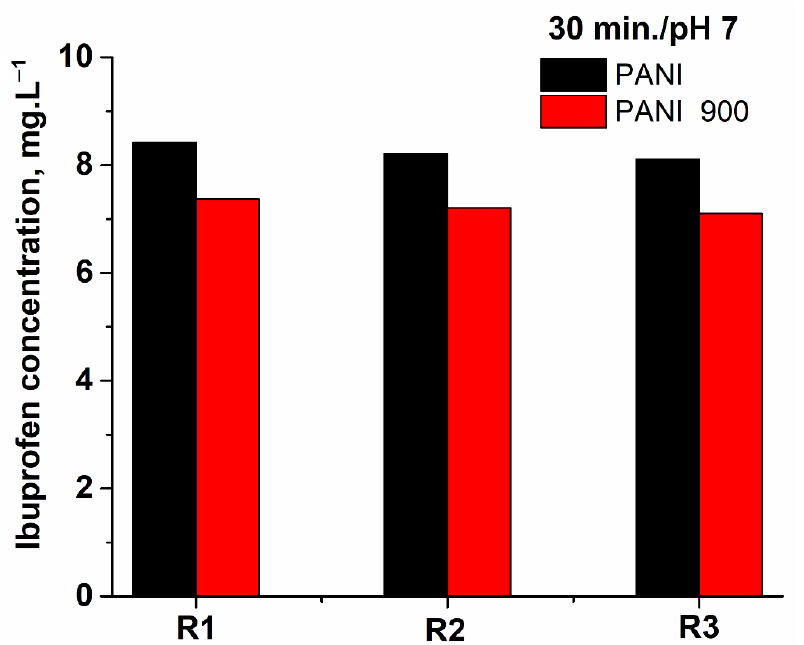
Figure 17. Preservation of catalytic systems’ activity after three cycles of